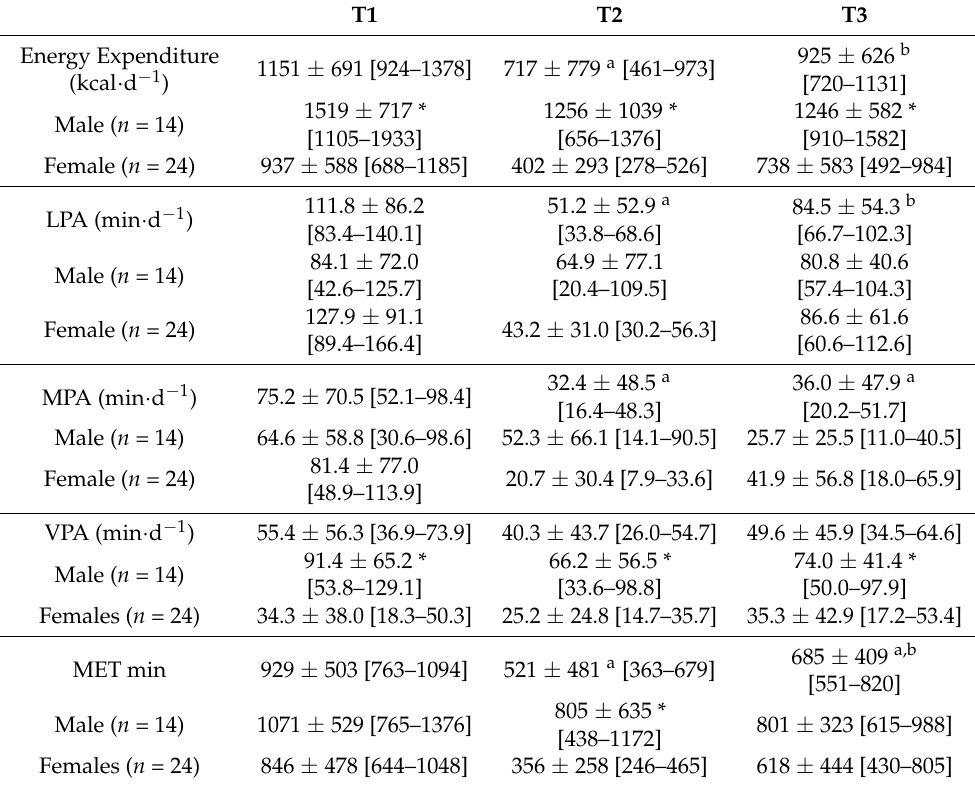
Table 2. Total daily energy expenditure and physical activity in undergraduate university students at the beginning of 1st year (T1), end of 1st year (T2), and end of 4th year (T3). Values are mean ± standard deviation [95% confidence